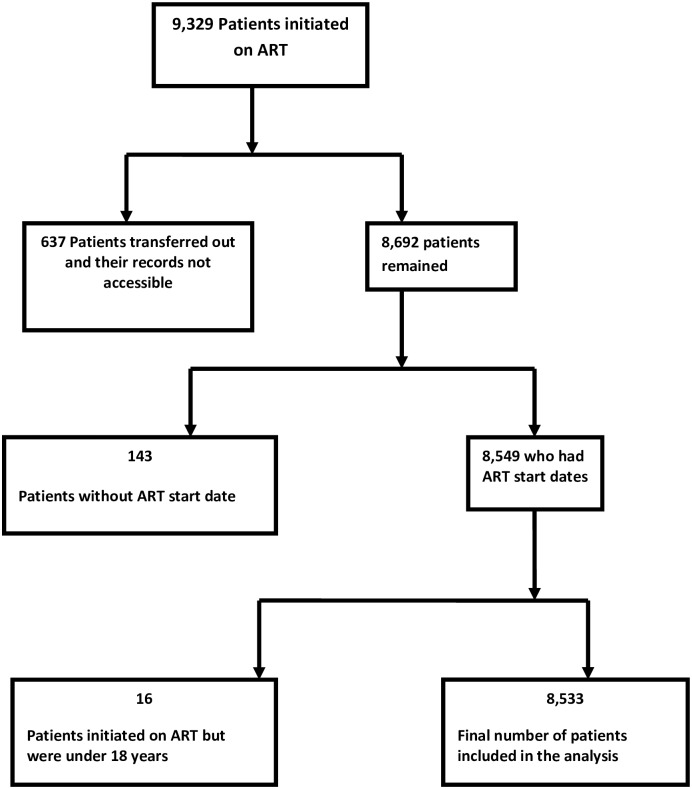
Summary profile of patients enrolled in HIV treatment at Mbarara Regional Referral Hospital, Uganda, 2006–2012.